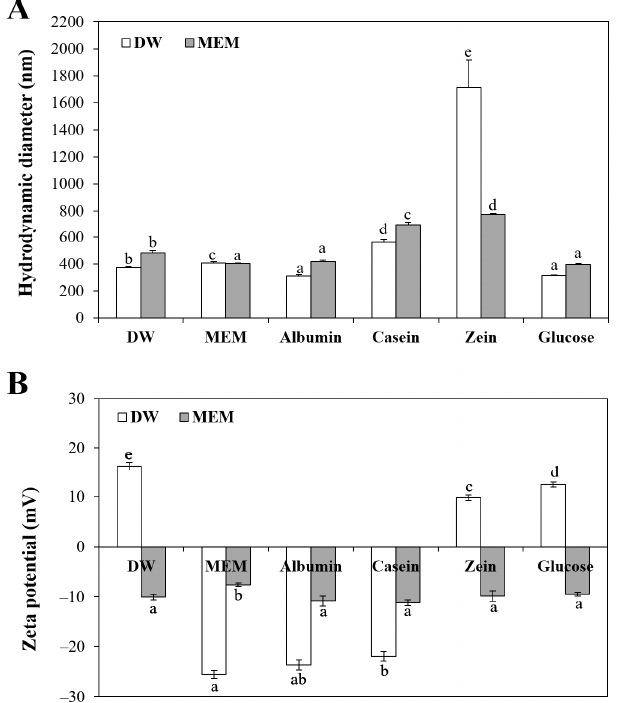
Figure 1. ( A ) Hydrodynamic diameters and ( B ) zeta potentials of ZnO NPs in food proteins or glucose, as measured by dilution in distilled water (DW) or cell culture minimum essential medium (MEM). Different lowercase letters (a–e) indicate significant differences among different matrices ( p < 0.05).